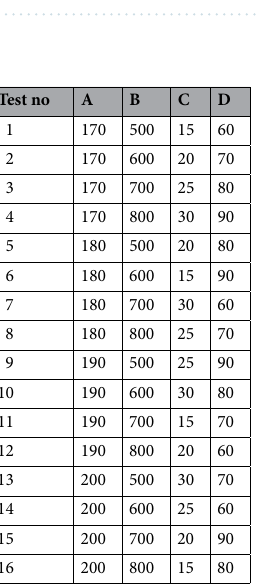
Table 3. Factor level table of orthogonal test.